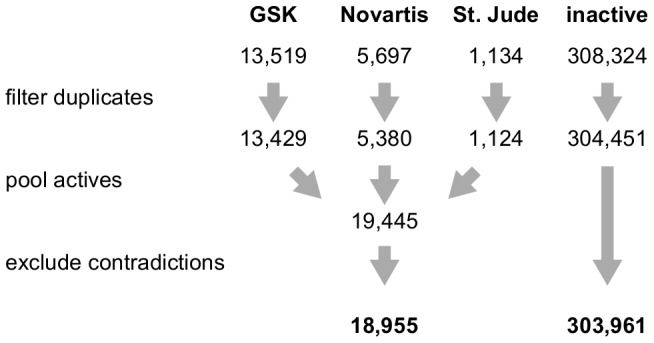
Data work-flow and library sizes during pre-processing of virtual target profiling.